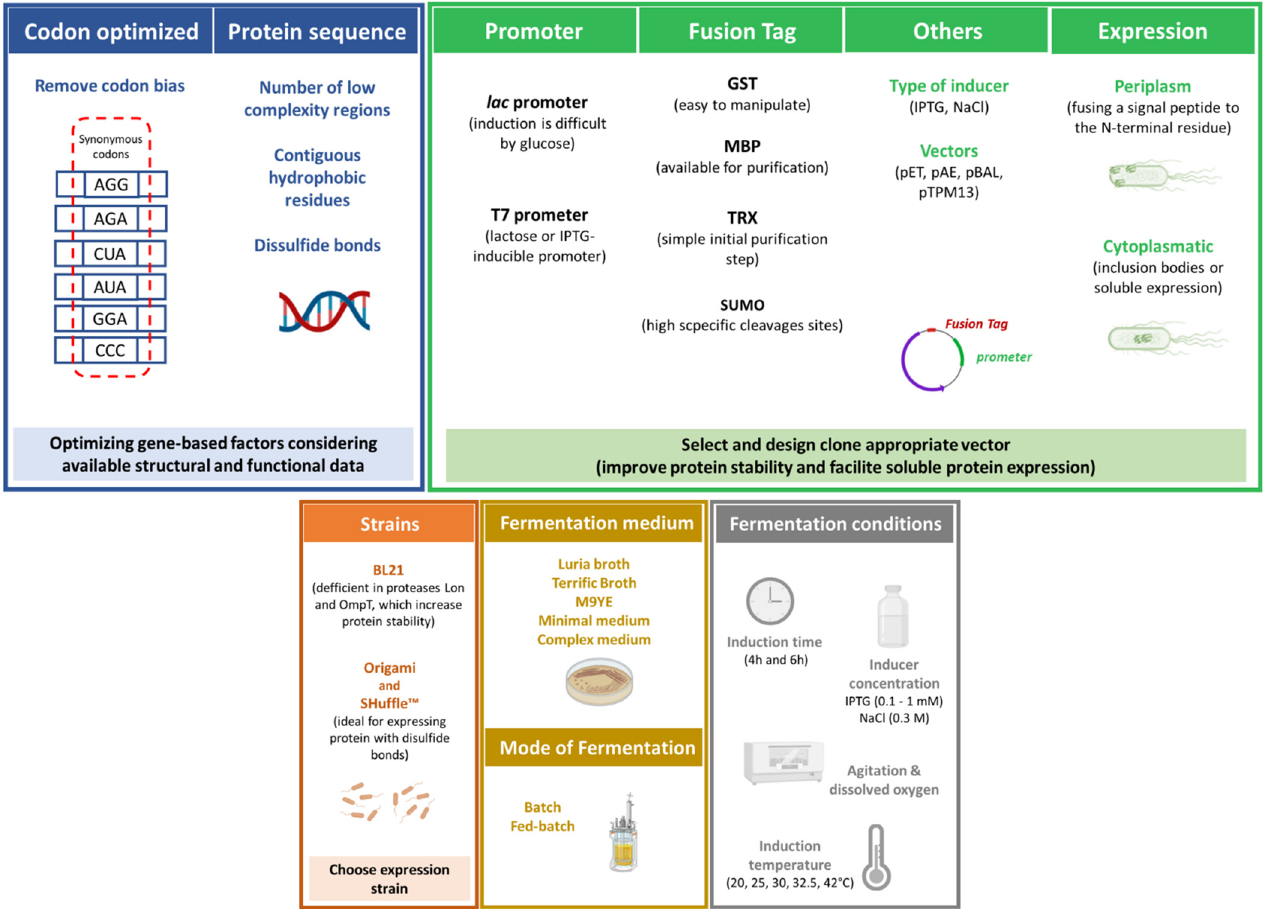
Figure 3. Optimized factors towards enhanced expression of IFNs using recombinant E. coli.